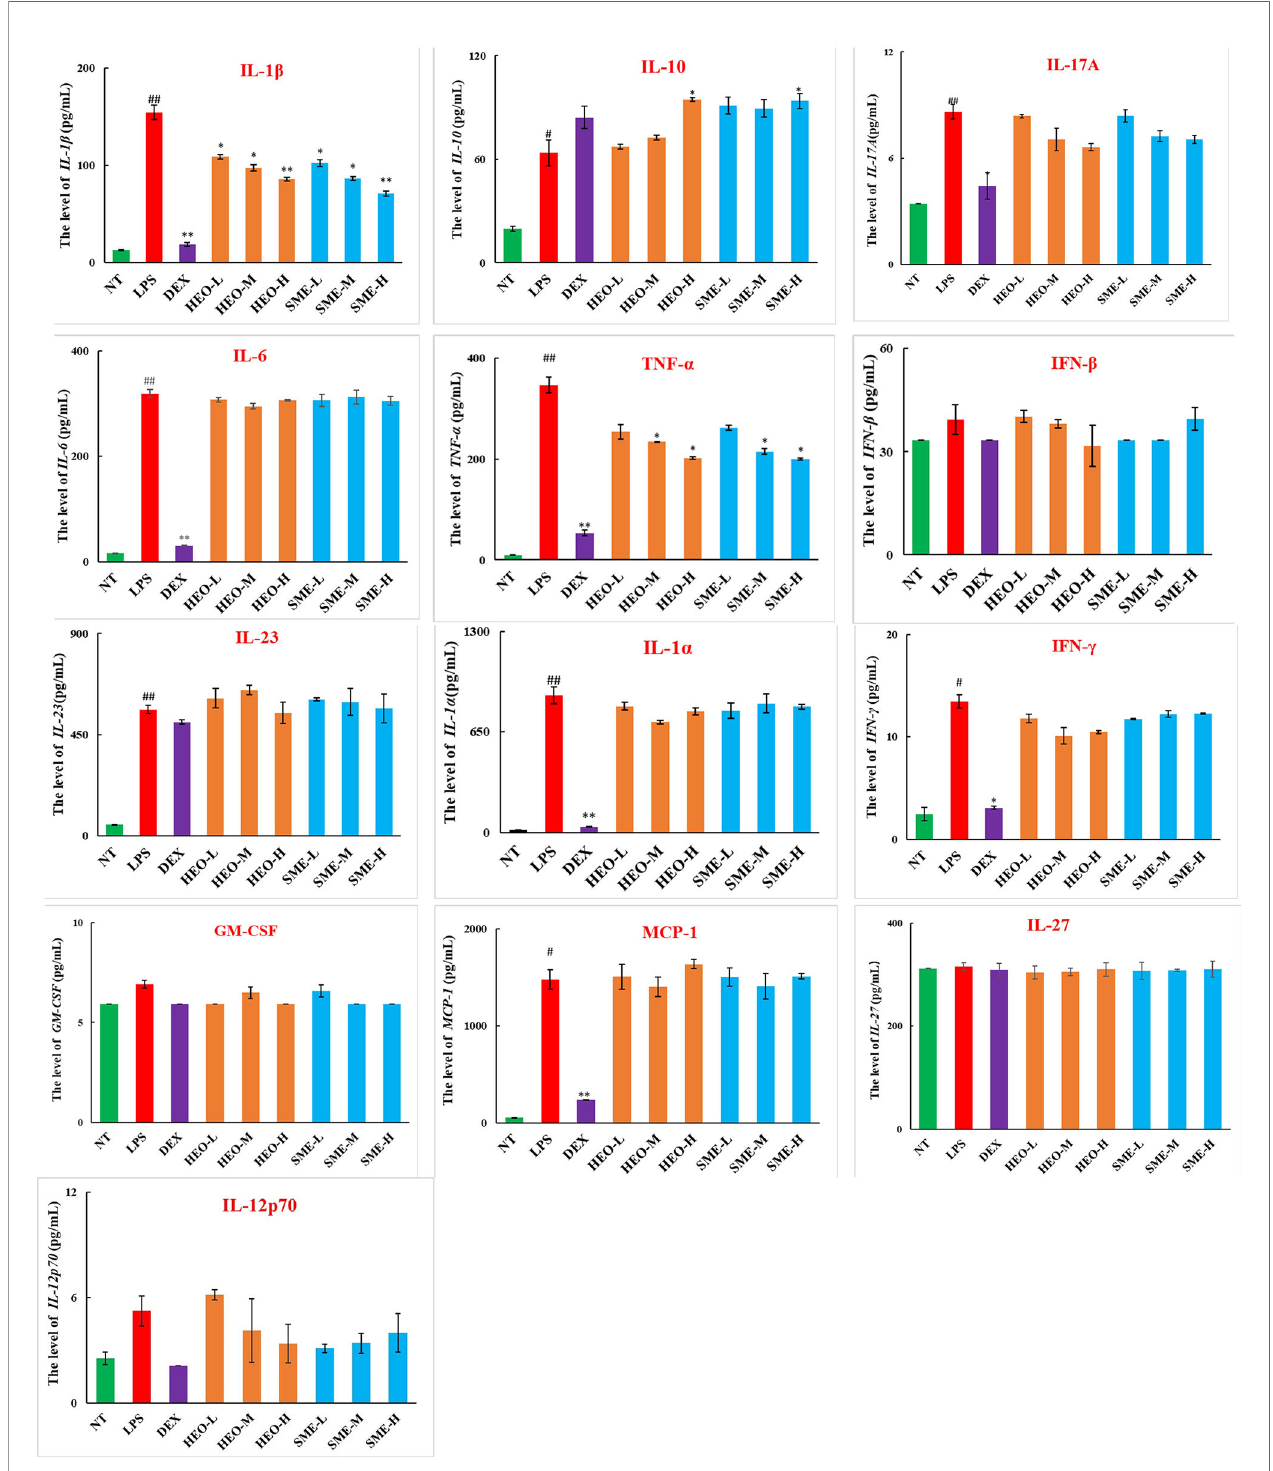
FIGURE 4 | Expression of 13 in fl ammatory factors in LPS-induced murine mastitis. Mean ± SD, n = 6. # P < 0.05, ## P < 0.01 compared to NT group, * P < 0.05, ** P < 0.01 compared to model